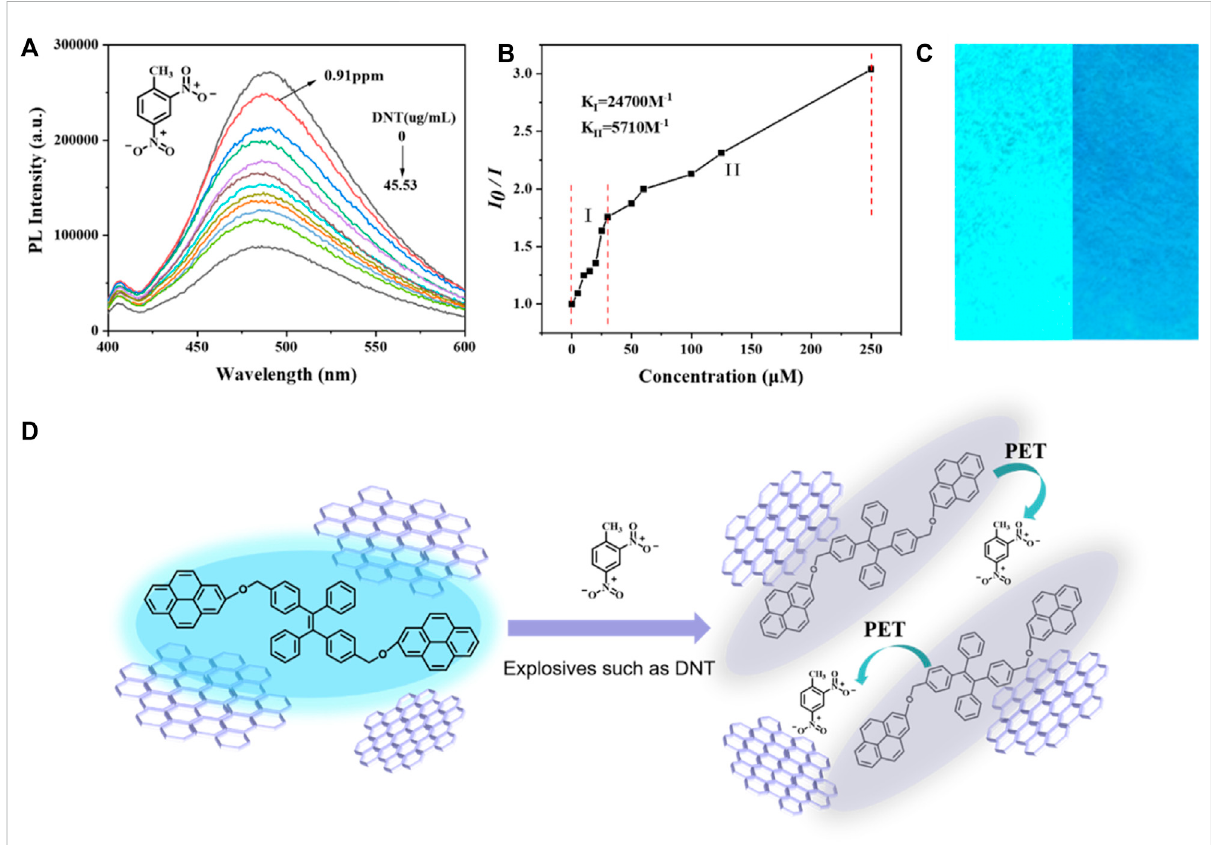
FIGURE 4 (A) PLspectraof rGO-TPEP withdifferentDNTamounts inaTHF/H 2 Omixture witha99%water fraction.rGO-TPEP concentration: 10 – 5 Mand excitationwavelength:350 nm. (B) RelativePLdiagramunderdifferentDNTconcentrations(I0=intensityat[DNT]=0 μ M). (C) Fluorescenceimages of rGO-TPEP adsorbed on fi lter papers dipped into a THF/H 2 O mixture (1:99, v/v, left) and then dipped into a DNT solution (right).